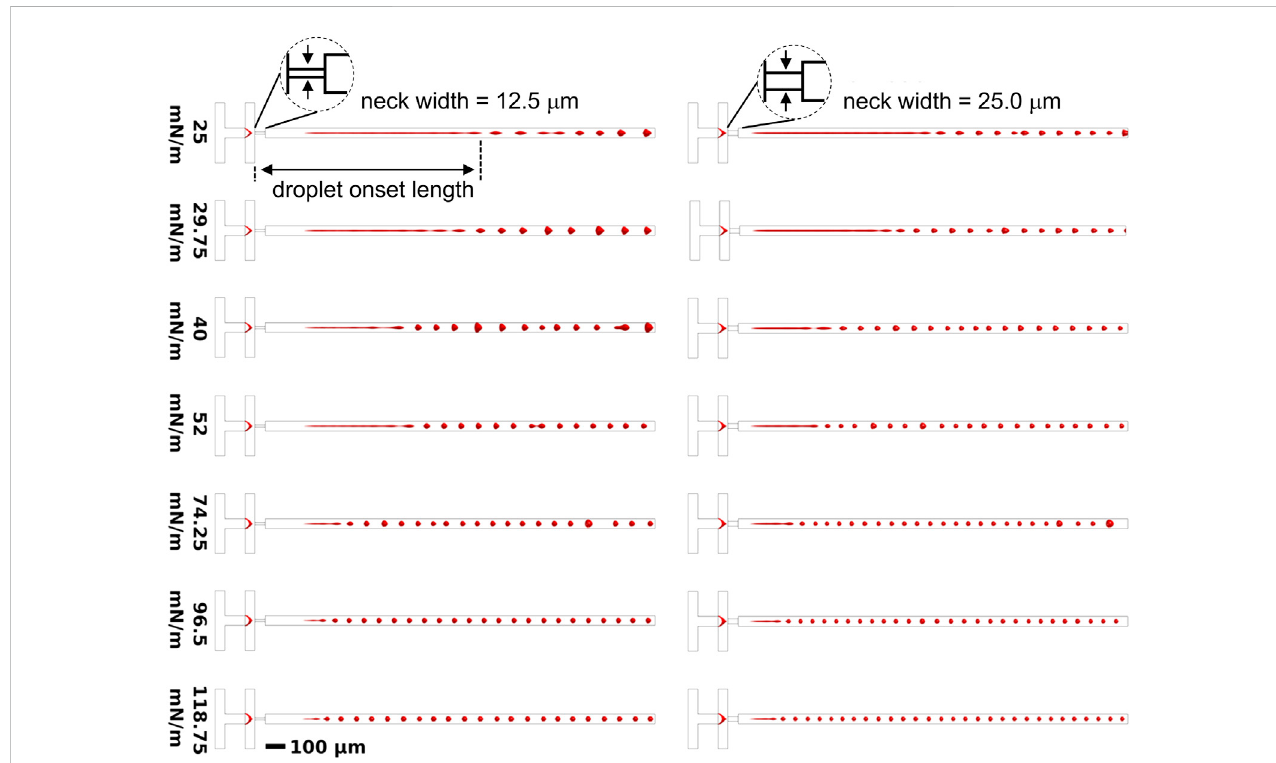
FIGURE 2 Top-downviewofanisosurfacerenderofstabledropletgenerationafter10 mscorrespondingtoaneckwidthof12.5 μ mand25 µmasafunctionofthe initial surface tension, σ 0 . Corresponding values for σ 0 are shown on the left-hand side of the fi gure.